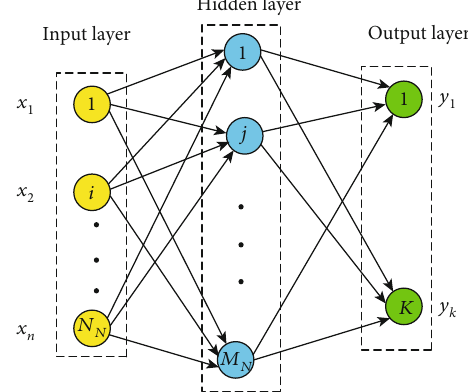
Figure 4: Schematic of feedforward neural network [28].